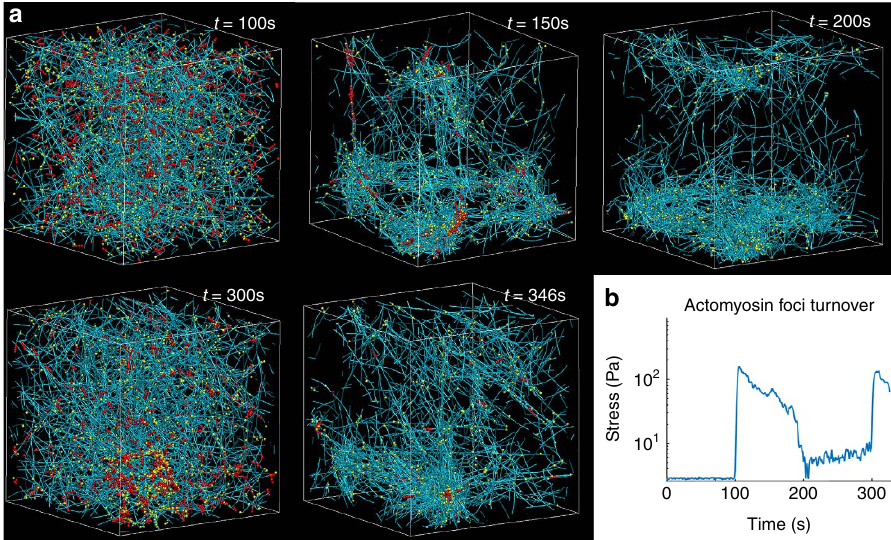
Figure 4 | Reversibility of actin aggregation in the active cytoskeleton. This network consists of 25 m M actin, 5% ACPs, 1% motors and an actin turnover rate of 300s (cid:3) 1 . ( a ) At t ¼ 100s, motors are activated and actin turnover is disabled, leading to aggregation over time. At t ¼ 200s, actin turnover is enabled, leading to foci disintegration and the regeneration of a homogeneous network. At t ¼ 300s, actin turnover is suppressed again, enabling foci to reform. ( b ) The stress versus time profile for the network in a , displaying the relation of foci formation and turnover to stress. Foci formation leads to large but transient stress build-up. Actin turnover enables the network to regenerate and allows for subsequent stress build-up, enhancing contractile behaviour over longer periods. This suggests the driving factors and functional implications of pulsatile actomyosin contractions and foci formation during embryogenesis. In these simulations, we used larger motors with 256 heads (rather than 64) which appear to be able to aggregate more crosslinked networks more quickly. Teal, yellow and red are actin filaments, ACPs and motors,